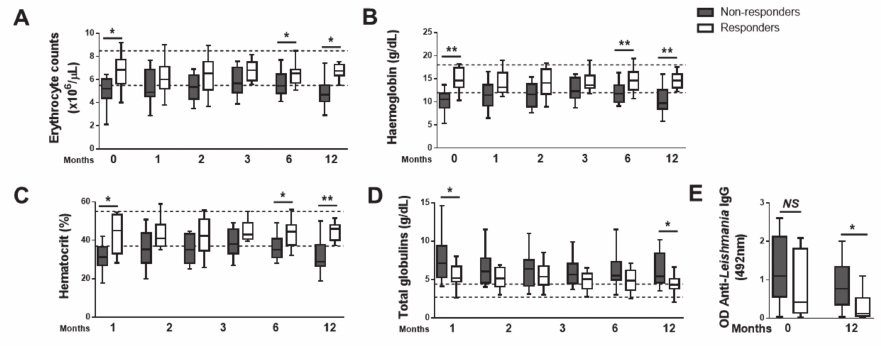
Figure 3. Success of anti- Leishmania therapy is associated with a restoration of erythrocyte, hemoglobin, hematocrit, as well as total and Leishmania -specific globulin values. Erythrocyte number ( A ) and the values of hemoglobin ( B ), hematocrit ( C ), total globulins ( D ) and anti- Leishmania IgG ( E ) were quantified in the serum at diagnosis (0) and upon 1, 2, 3, 6 and 12 months of anti- Leishmania treatment. Data are shown as box and whisker plot format, Responder dogs ( n = 12), Non responder dogs ( n = 14). * p < 0.05; ** p < 0.01.